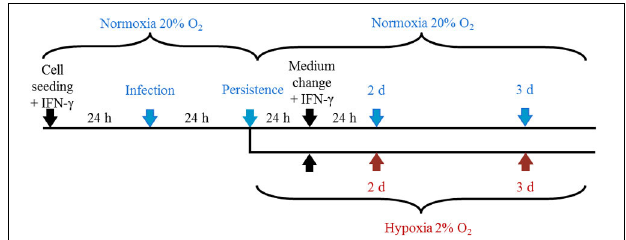
FIGURE 1 | Representation of the experimental setup. Cells were cultured under normoxia for 24h in the presence of IFN- γ (5U/mL) and were infected with C. trachomatis (2 IFU/cell) the following day. After 24h, cells were further incubated under normoxia (20% O 2 ) or transferred to hypoxic (2% O 2 ) conditions with constant IFN- γ supplementation before samples were collected at the indicated time points.